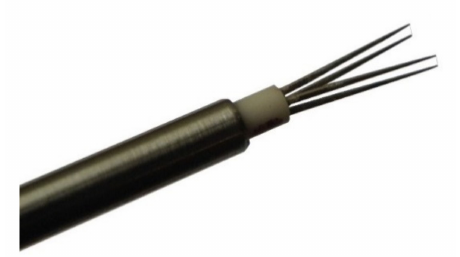
Figure 1. Two-wire measuring